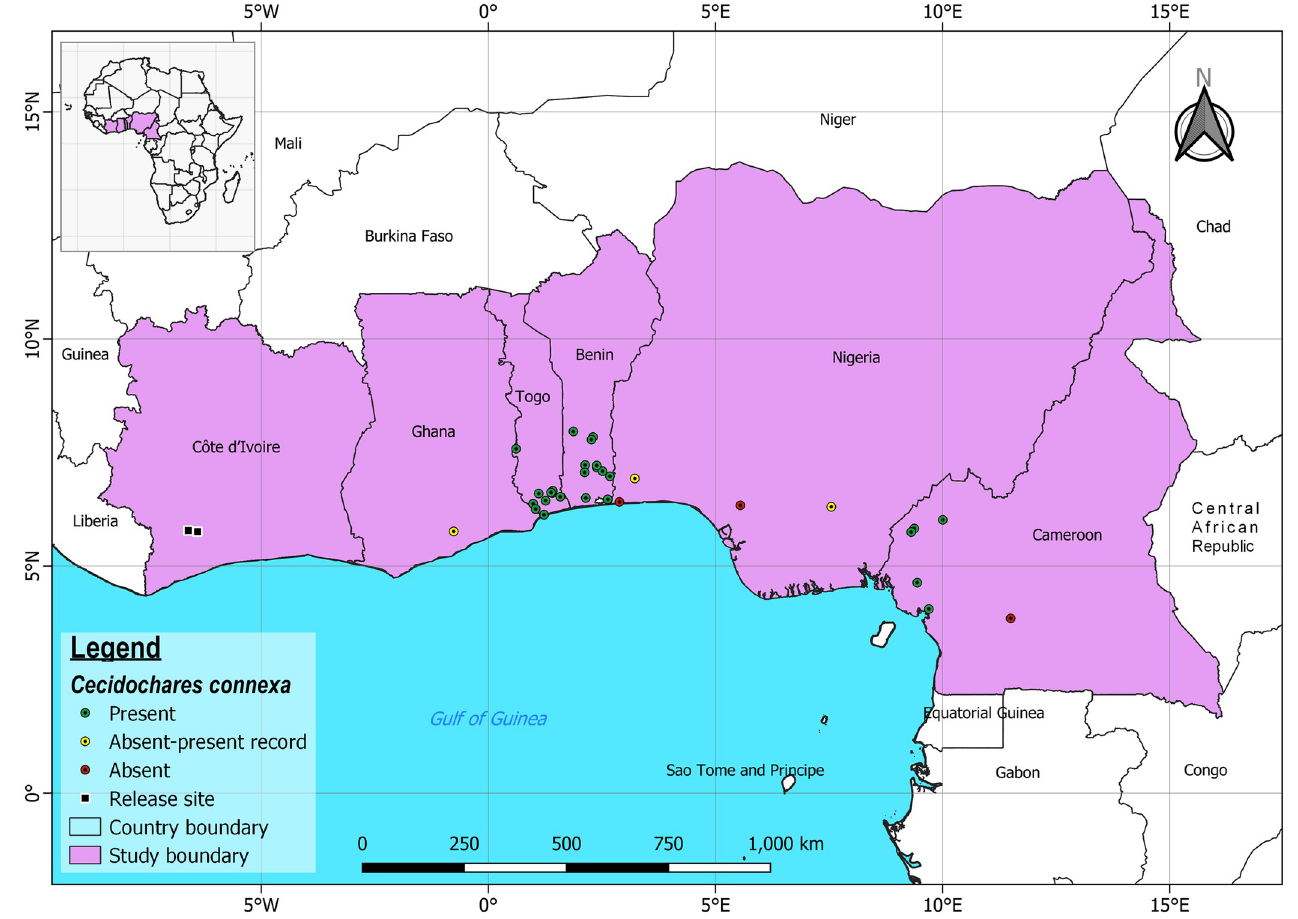
Fig 2. Occurrence of C . connexa in Ghana, Togo, Benin and Nigeria (West Africa) and Cameroon (Central Africa) in the sampling efforts from 2018 to 2020. Absent-present records indicate locations where galls were not seen in 2016 but were observed in the current surveys. See (S1 Table) for further details. This figure was generated in QGIS (version 3.16.1 Hannover) https://qgis.org/downloads/ and the source files were obtained from Natural Earth https://www.